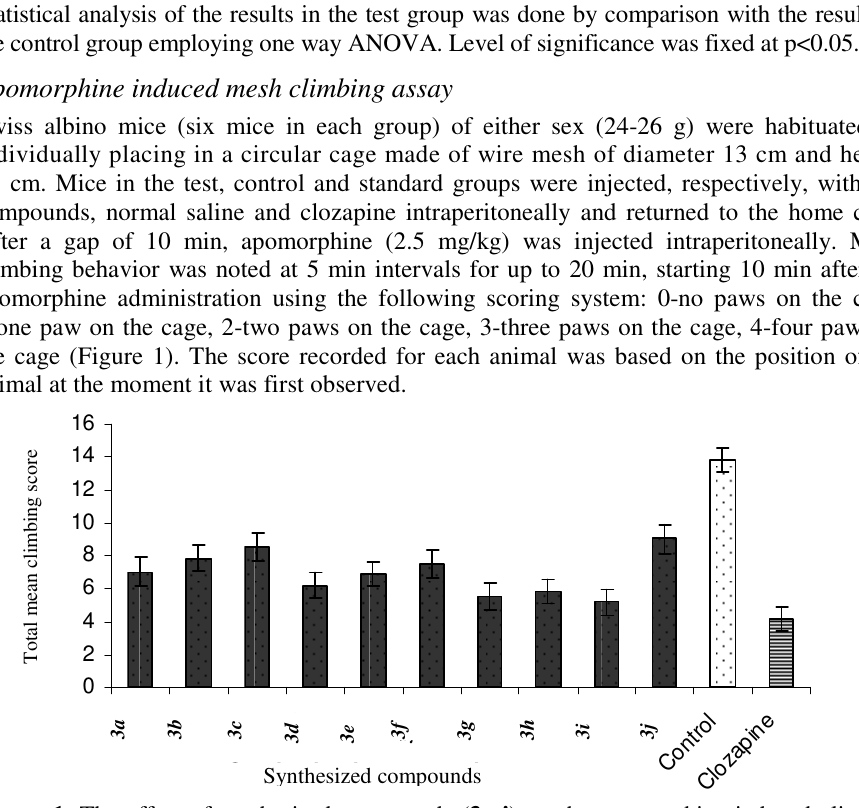
Figure 1. The effect of synthesized compounds ( 3a-j ) on the apomorphine induced climbing behavior . (Each column represents the mean ±SEM of total climbing score for group of six mice assessed at 5-min intervals for 20 min, starting 10 min after apomorphine treatment. A score of 20 is the maximum possible. All values statistically significant with respect to control at p<0.05) . Antagonism of 5-hydoxytryptophan (5-HTP) induced head twitches Swiss albino mice in the control group (n=6) was injected with pargyline (75 mg/kg, i.p) in